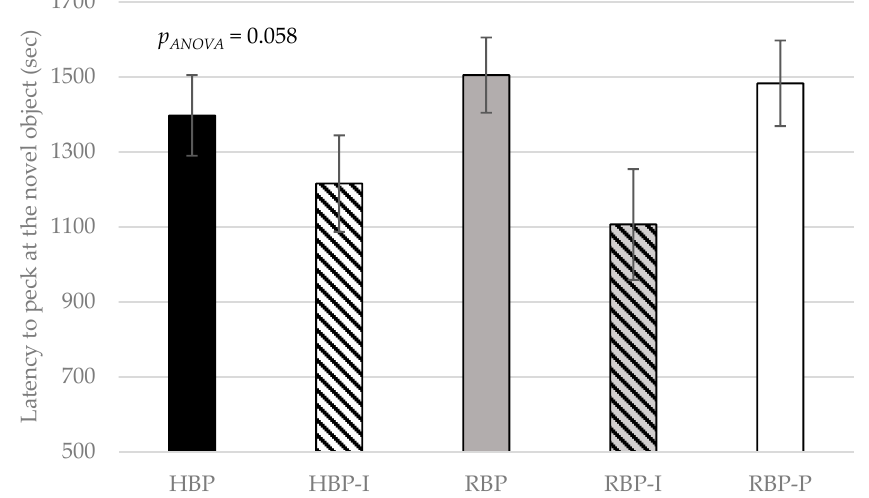
Figure 3. Effect of protein level, inositol or phytase on the latency to peck at the novel object (sec) by Lohmann LSL lite hens. HBP: High balanced protein; RBP: Reduced balanced protein; I: Inositol; P: Phytase.